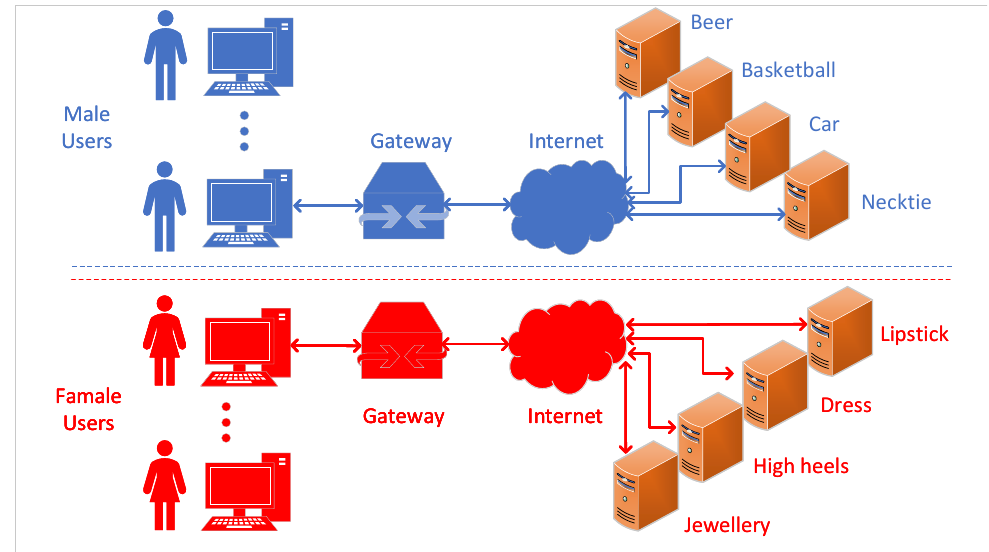
Figure 1. A general example to explain that user demographics may exert influence on visits to